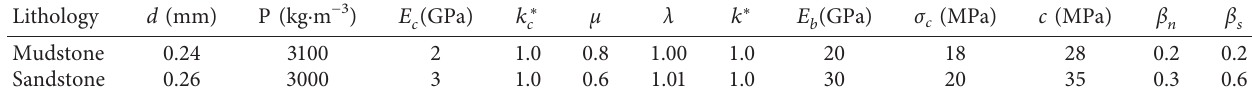
Table 5: Mesoscopic parameters of sandstone and mudstone materials.